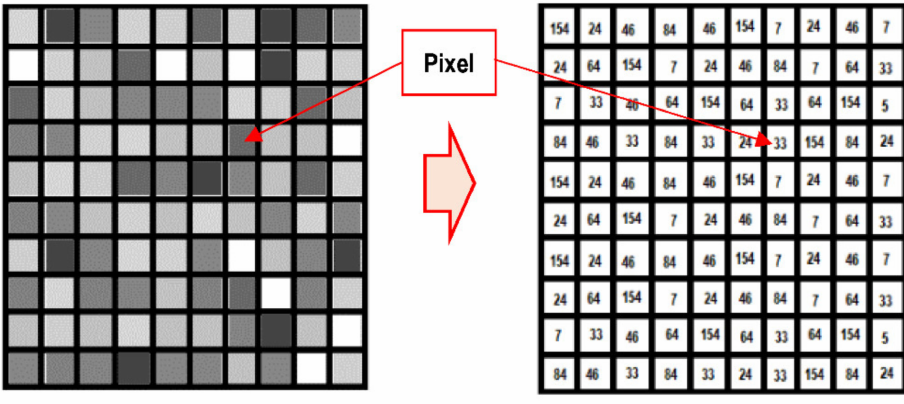
Figure 8. Digital image by an arrangement of pixels represented as numbers.